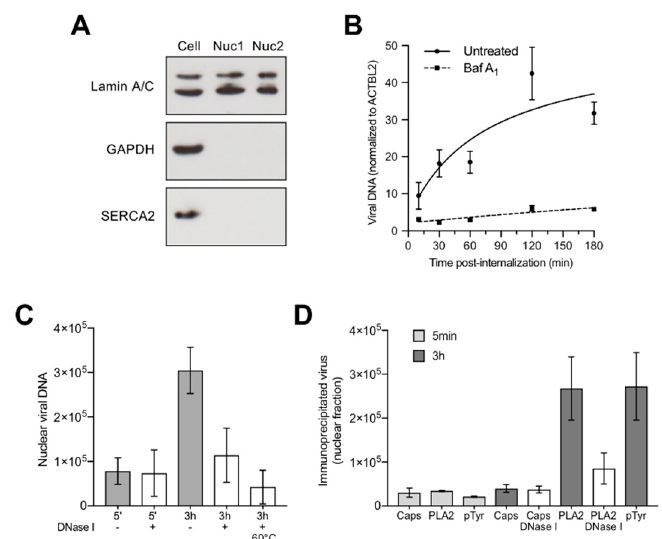
Figure 6. Characterization of incoming B19V associated to the nuclear fraction. ( A ) Isolation of intact nuclei without cytoplasmic contamination. The purity of the nuclear fraction and the absence of cytoplasmic contamination were examined by the detection of lamin A / C (nuclear marker) and SERCA2 ATPase (ER marker) and GAPDH (cytoplasmic marker) by Western blot. Nuc1 and Nuc2; two independent nuclear preparations. ( B ) Accumulation of B19V in the nuclear fraction at increasing times pi. Nuclei isolated after 5 min or from cells treated with BafA 1 served as negative controls. The results were normalized by the quantification of the β -actin-like gene 2 (ACTBL2). ( C ) Nuclease sensitivity of virions associated to the nuclear fraction. Nuclei isolated after 5 min served as background control. Nuclear fractions prepared 3 h pi were treated at 60 ◦ C for 5 min to control the activity of DNase I. qPCR values represent geq / µ L. ( D ) Immunoprecipitation of virions associated to the nuclear fraction. Nuclei isolated after 5 min served as background control. pTyr; phosphotyrosine antibody. qPCR values represent geq / µ